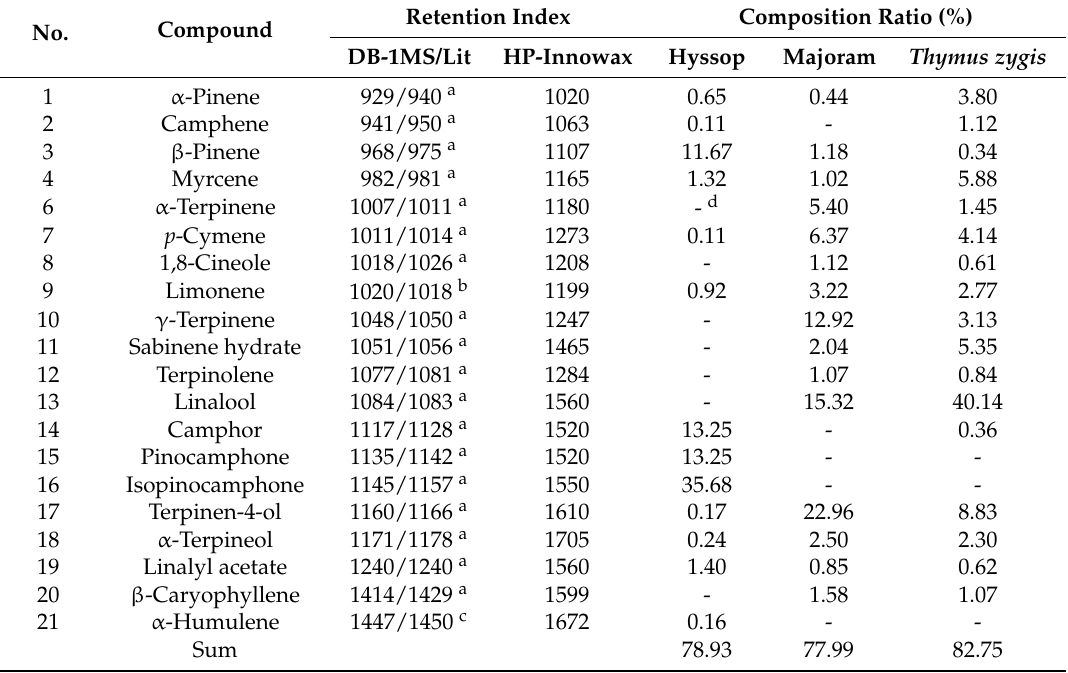
Table 2. Chemical analysis of active essential